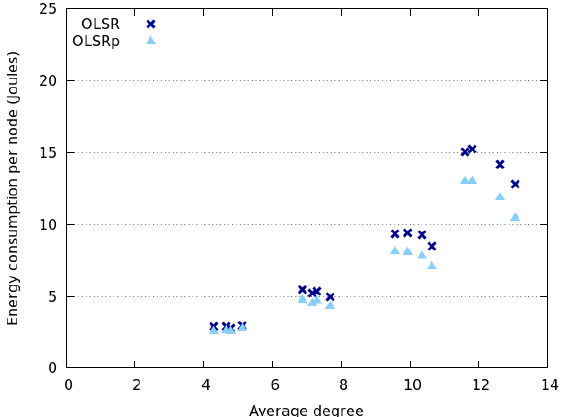
Figure 10. Energy consumption versus network degree when nodes follow a Nomadic